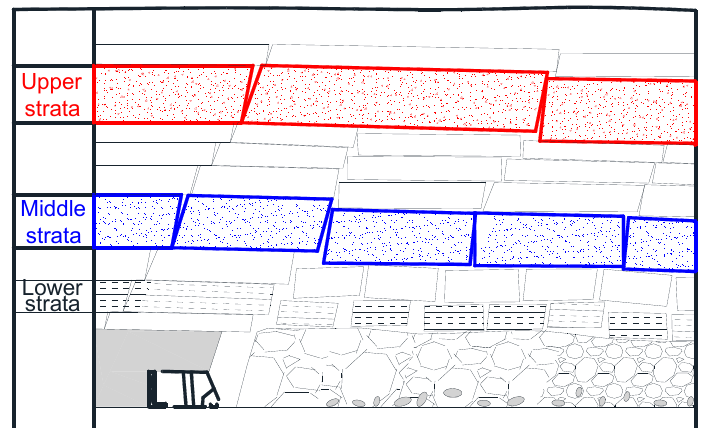
Figure 2. Roof structure during mining in an extra-thick coal seam.